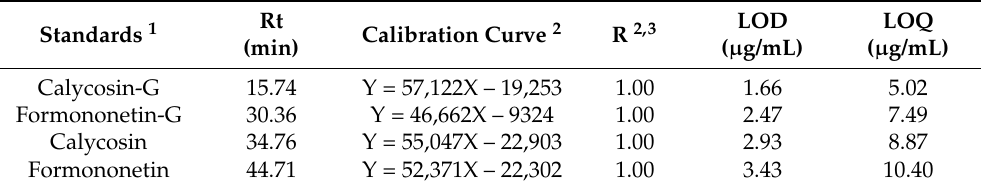
Table 2. Calibration curves, the LOD and LOQ values of standards for quantification in NF-AM and MG5276F-AM ( n =